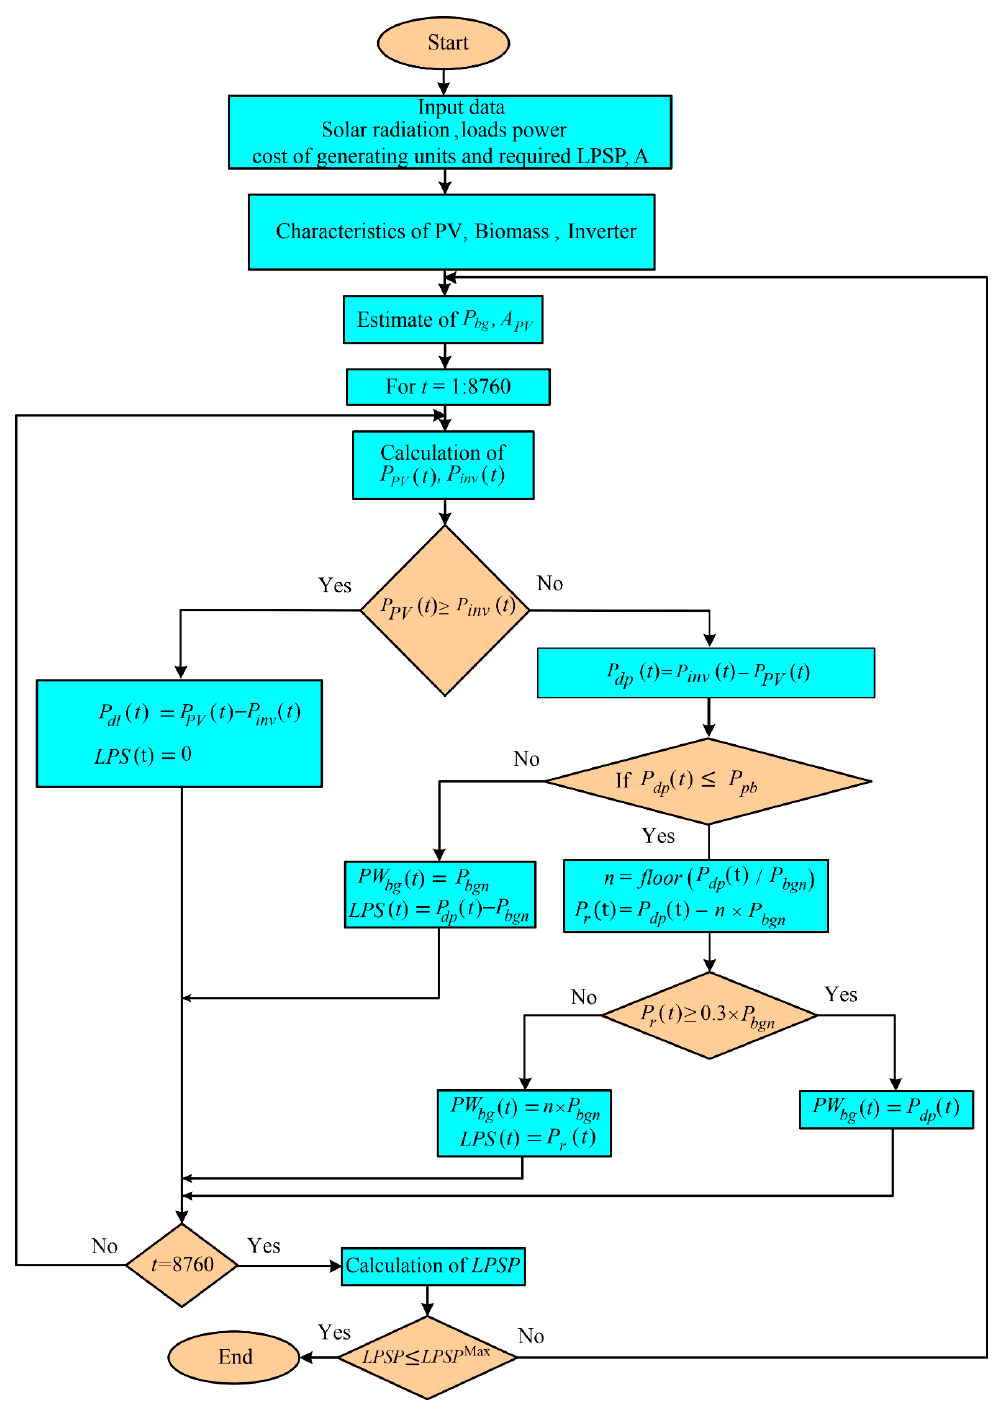
Figure 2. Power management of the PV/Biomass hybrid renewable energy sources (RES).